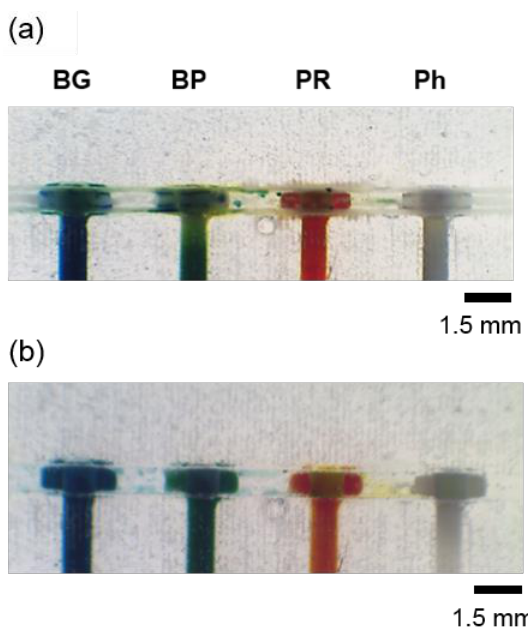
Figure 5. Picture of the section of the pH sensor device ( a ) after washing it with DI water and ( b ) after the reaction of an equimolar mixture of HCl and NaOH was performed inside the meandering channel and passed through the sensing areas.